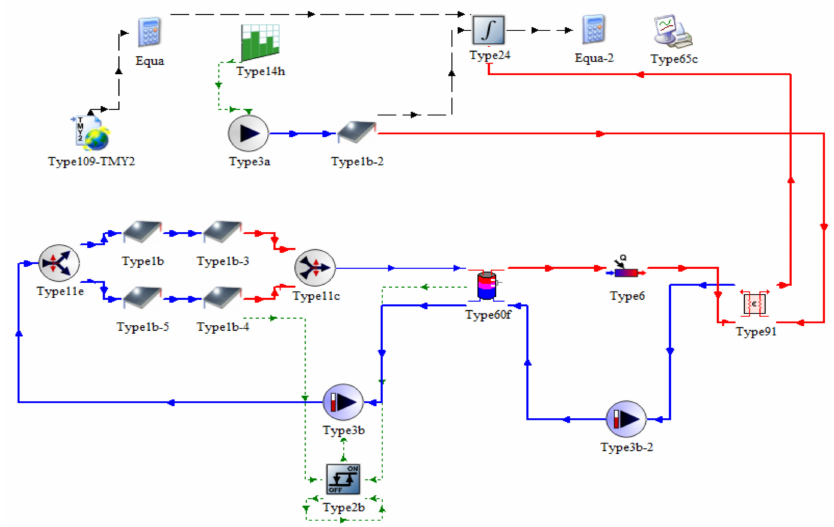
Figure 4. Simulation